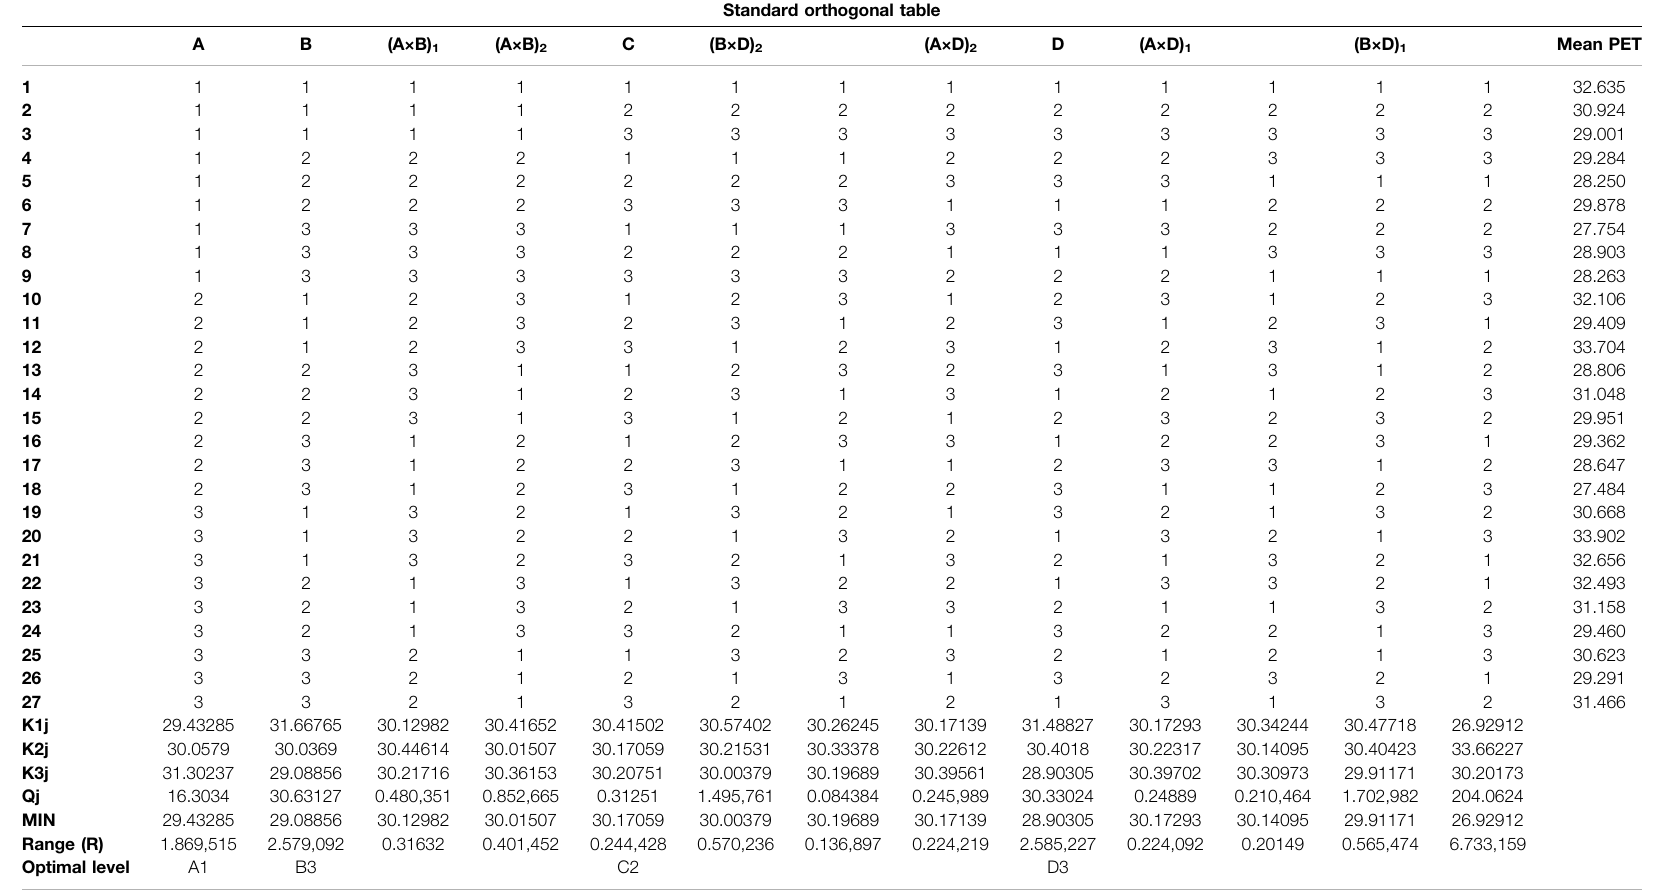
TABLE 6 | Results of models in orthogonal experimental design of mix